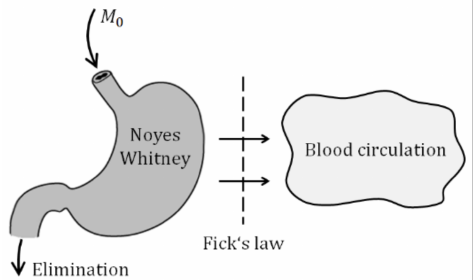
Figure 3. Idea of drug